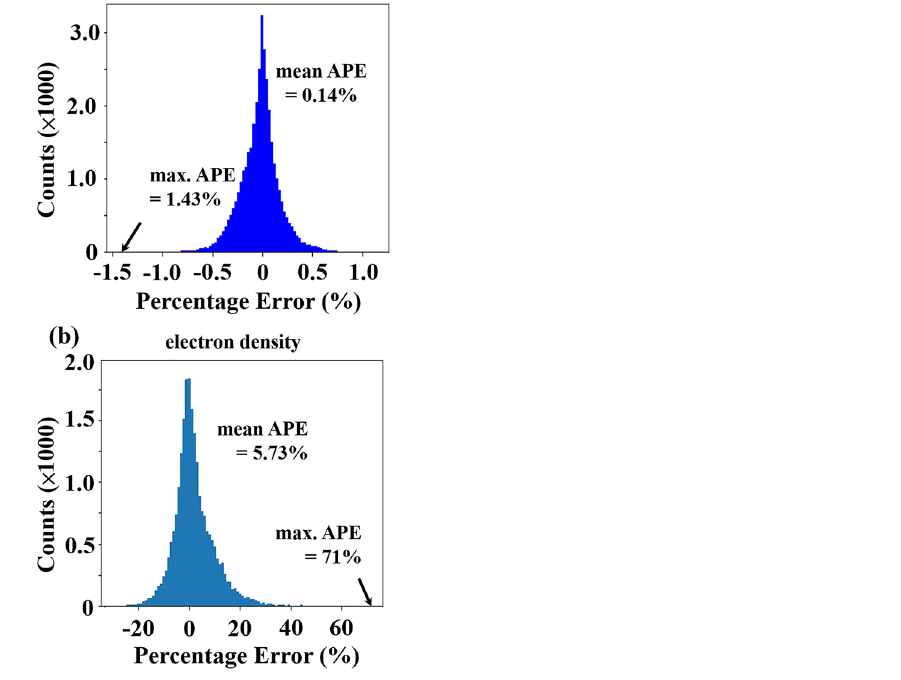
Figure 5. Percentage error histogram for the predicted electrostatic potential ( a ) and electron density ( b ). Each histogram compiles error values of 5 testing data and there are 7168 (4480) mesh points in each testing data of electrostatic potential (electron density), leading to 35,840 (22,400) total counts. Due to zero electron density in the gate oxide, the mesh points in the regions are uncounted, resulting in fewer total counts in ( b ). APE indicates absolute percentage